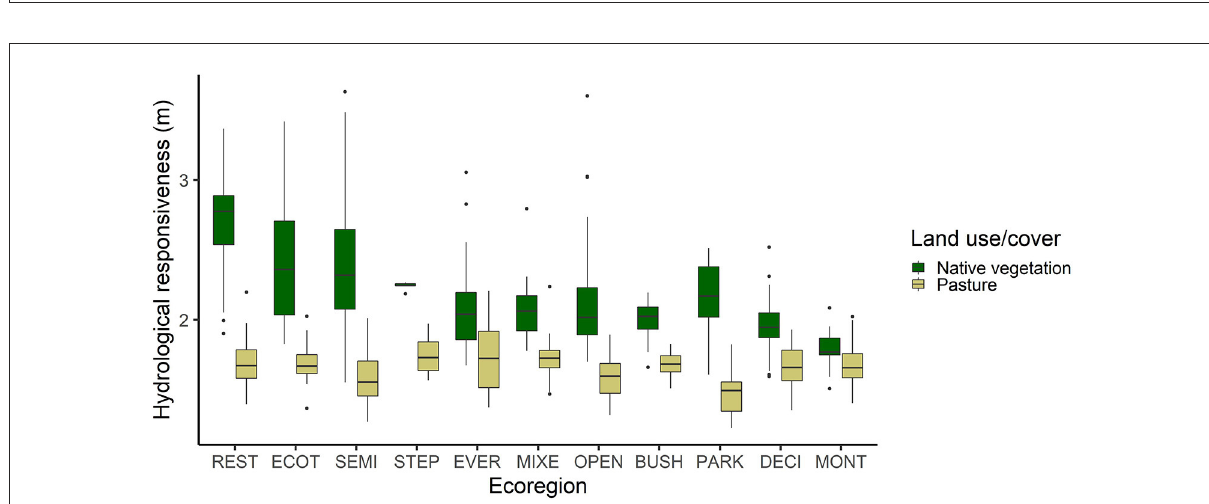
FIGURE3 Hydrological responsiveness of natural cover and pasture in the 11 ecoregions of the Atlantic Forest, Brazil. REST, Arboreal restinga and mangrove; BUSH, Bushy grassland; DECI, Deciduous broadleaved forest; ECOT, Ecotone; EVER, Evergreen broadleaved forest; MIXE, Mixed needle-broadleaved forest; MONT, Montane and upper montane forest; OPEN, Open ombrophilous forest; PARK, Parkland savanna; SEMI, Semideciduous broadleaved forest; STEP, Steppe